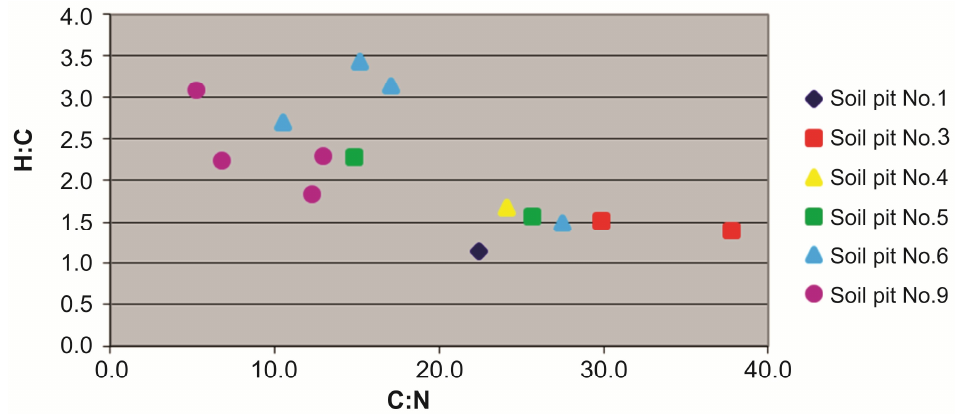
Figure 9. Soil organic matter Van Krevelen diagram of fallow soils on Gogland: ratios H:C and C:N (No. of soil pits, according to Figure